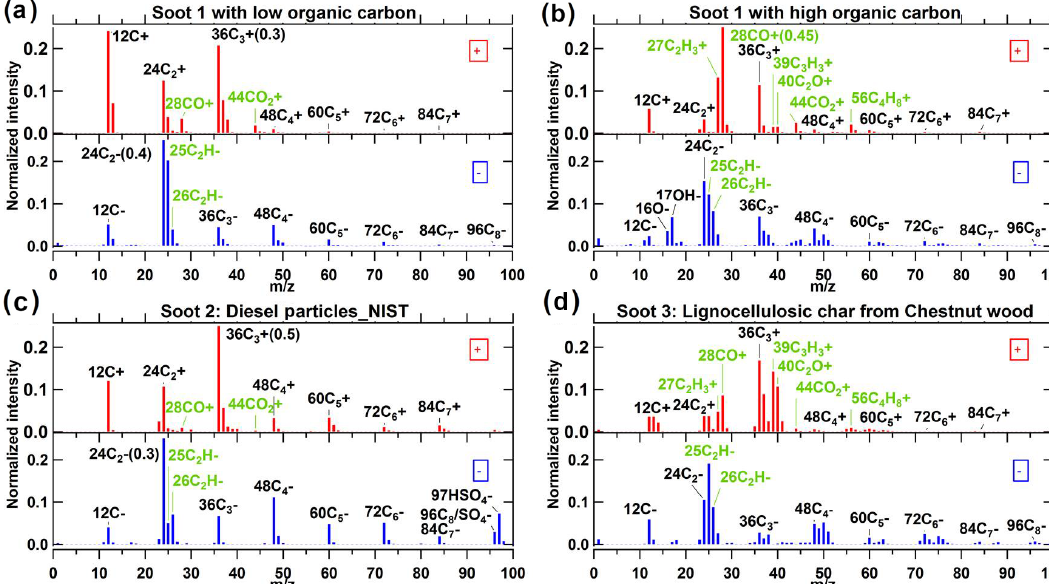
Figure 6. Average mass spectra for soot particles with (a) high elemental carbon (EC) and low organic carbon (OC) content, and (b) low EC and high OC from combustion of propane in a soot generator and transferred to a stainless-steel cylinder of ∼ 0.2m 3 volume, as well as soot particles of (c) diesel particles (NIST) and (d) lignocellulosic char from chestnut wood. In (a) and (c) , the numbers in brackets beside peak 36 + and 24 − are the exact intensity values for them. The OC signatures are labelled in green. The numbers of spectra averaged for each spectrum are 617 (a) , 347 (b) , 533 (c) and 390 (d)